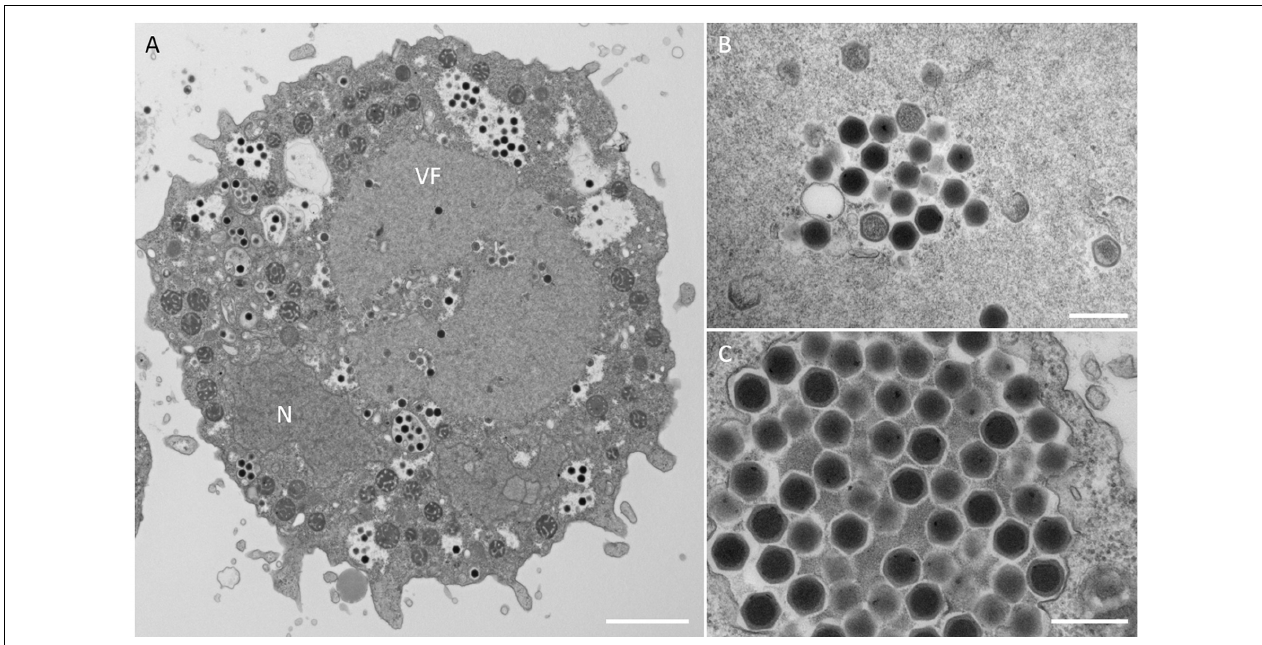
FIGURE 4 | TEM images of ultrathin sections of amoeba cells infected with the new viruses isolated from the Tatakaigawa River in Kyoto (named kyotovirus). (A) TEM image of a typical virion factory (VF) in the cytoplasmic region of the amoeba cells. N indicates an amoeba cell nucleus. Scale bar: 2 µ m. (B) Enlarged image of virus particles in VF. Scale bar: 400 nm. (C) Enlarged image of viral particles in the amoeba cytoplasm. Scale bar: 400 nm.